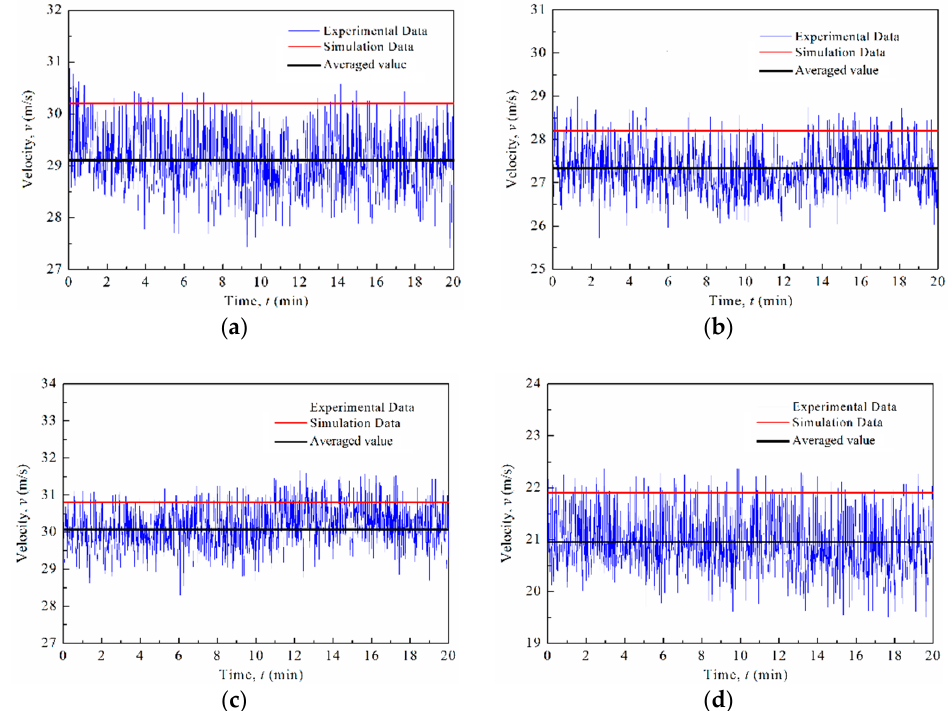
Figure 18. Comparison of experimental and simulation data: ( a ) Measurement point 1, v t = 5 km/h; ( b ) Measurement point 2, v t = 5 km/h; ( c ) Measurement point 1, v t = 10 km/h; ( d ) Measurement point 2, v t = 10 km/h